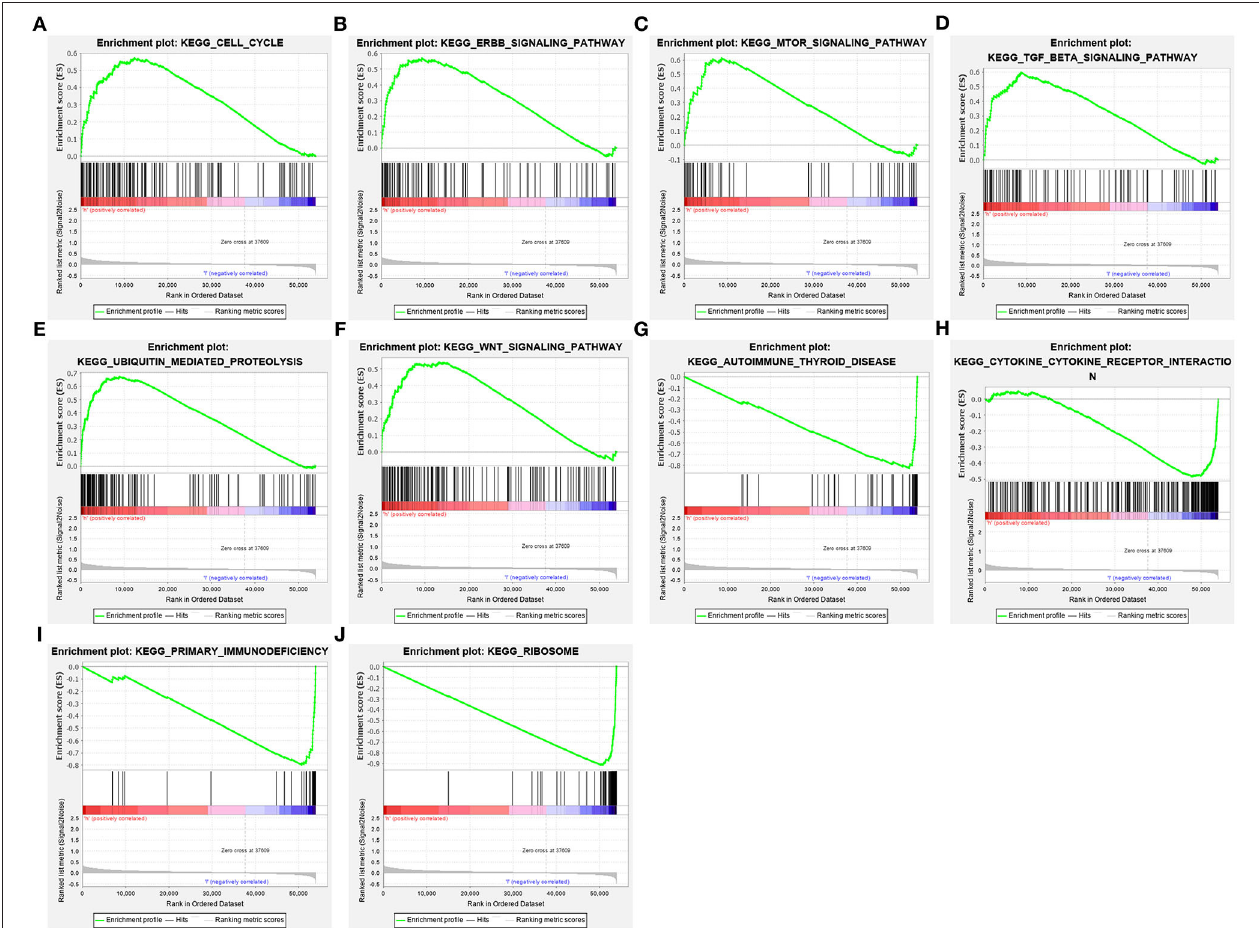
FIGURE 7 | Activated pathways involved in the pyroptosis-related gene signature by GSEA. (A) Cell cycle, (B) ERBB signaling pathway, (C) mTOR signaling pathway, (D) TGF-beta signaling pathway, (E) ubiquitin mediated proteolysis and (F) WNT signaling pathway were activated in high-risk samples. (G) Autoimmune thyroid disease, (H) cytokine-cytokine receptor interaction, (I) primary immunodeficiency, and (J) ribosome were activated in low-risk samples.